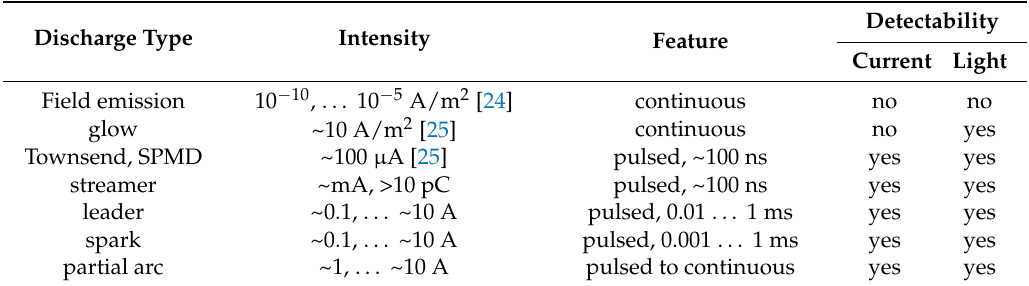
Table 1. Gaseous discharge types caused by insulation defects, which are summarized according to their intensities, features and detectabilities.